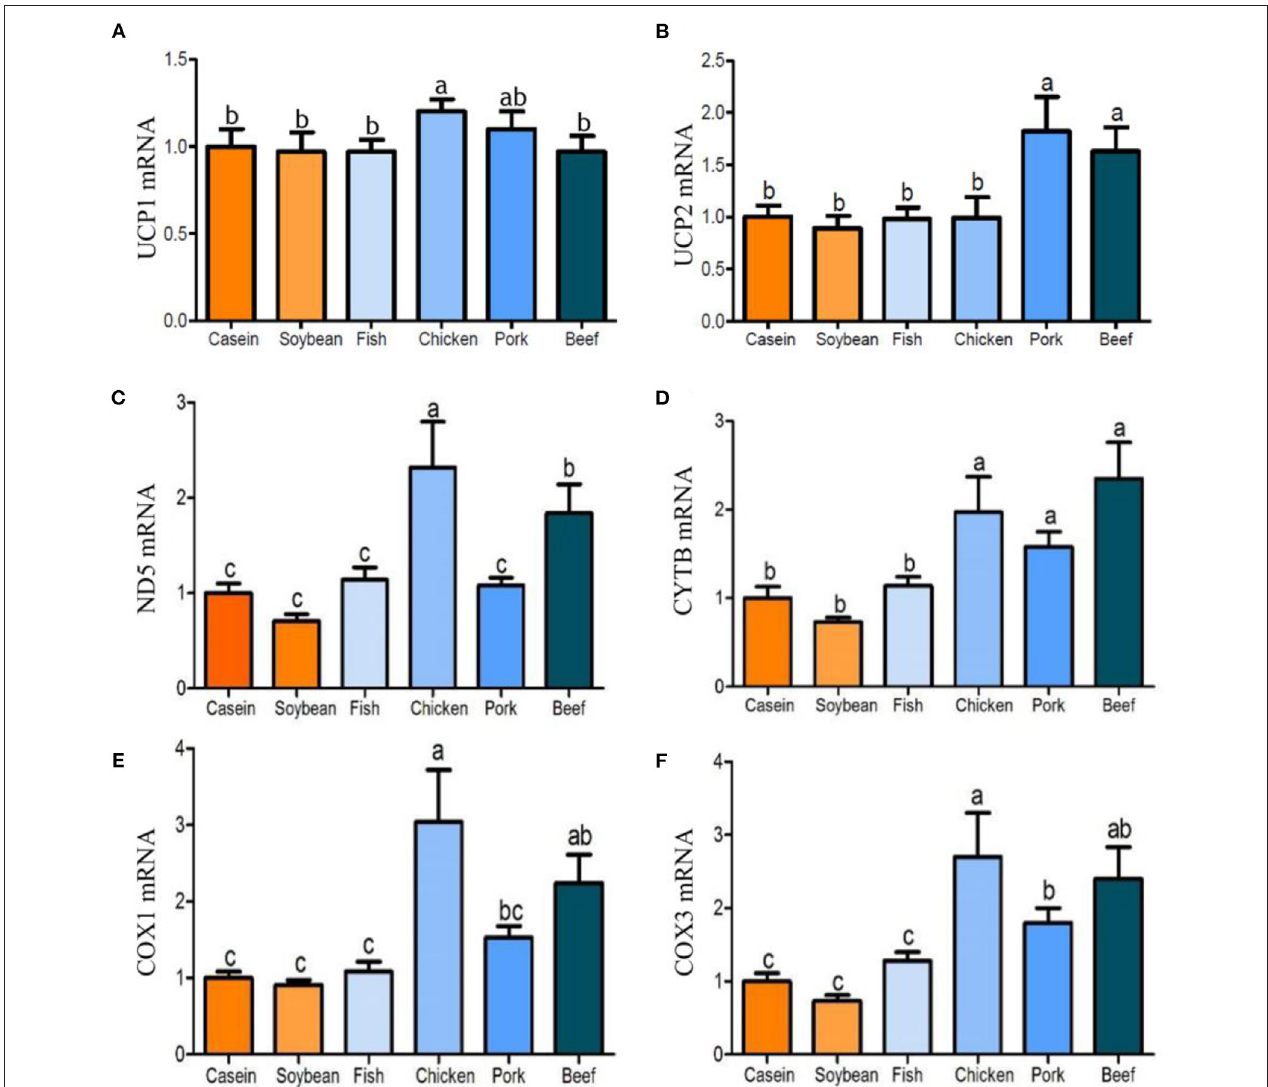
FIGURE 5 | (A–F) Effect of dietary casein, soy and meat proteins on rat liver mitochondrial uncoupling and respiratory chain related genes. Values are presented as the means ± SD. Groups were compared by one-way ANOVA followed by Duncan’s multiple range tests. Letters a–c represent significant differences between diet groups ( p <